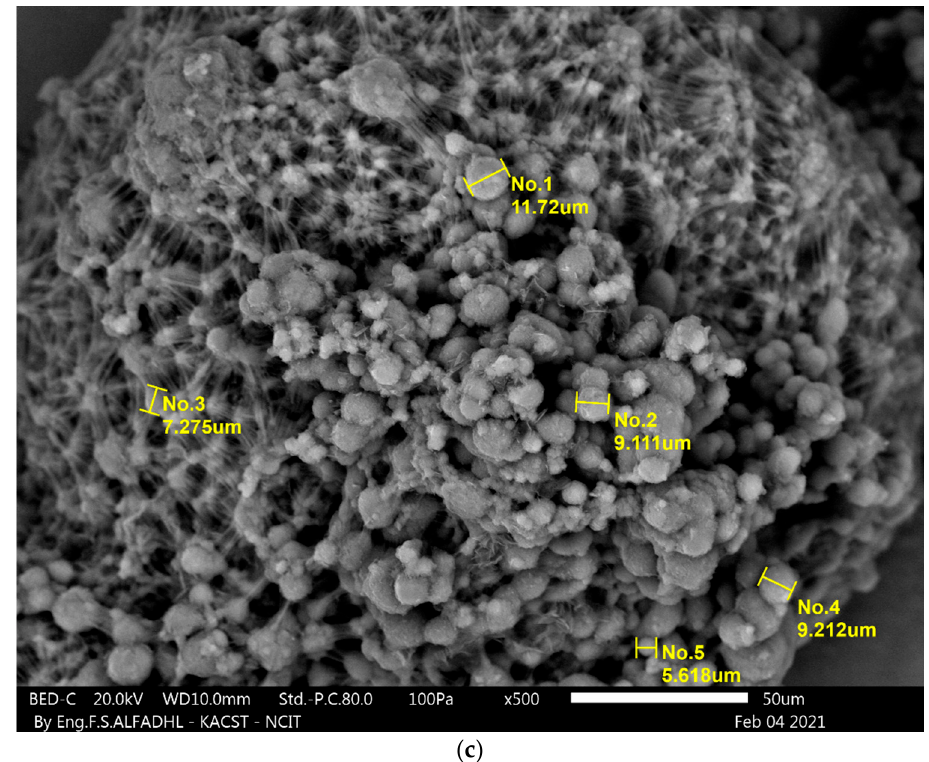
Figure 3. SEM result of polymer and catalyst particle in various [Al]/[Ti] molar ratios: ( a ) 309, ( b ) 773, and ( c ) 1236.